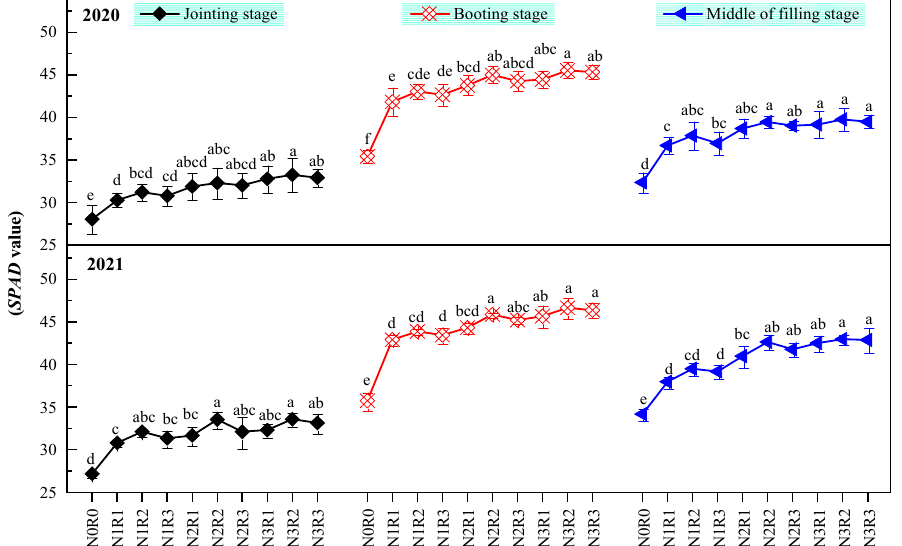
Figure 1. The effects of nitrogen application method on chlorophyll content of flag leaf. Values were means ± SD. Different letters indicated significant difference within the same year under the treatments of four nitrogen levels and four ratios of basal to topdressing by LSD test (ANOVA) at the 5% level. Four nitrogen fertilization levels: N0, 0 kg ha − 1 ; N1, 120 kg ha − 1 ; N2, 180 kg ha − 1 ; N3, 240 kg ha − 1 . Four ratios of basal N to topdressing: R0, 0:0; R1, 7:3; R2, 6:4; R3, 5:5.